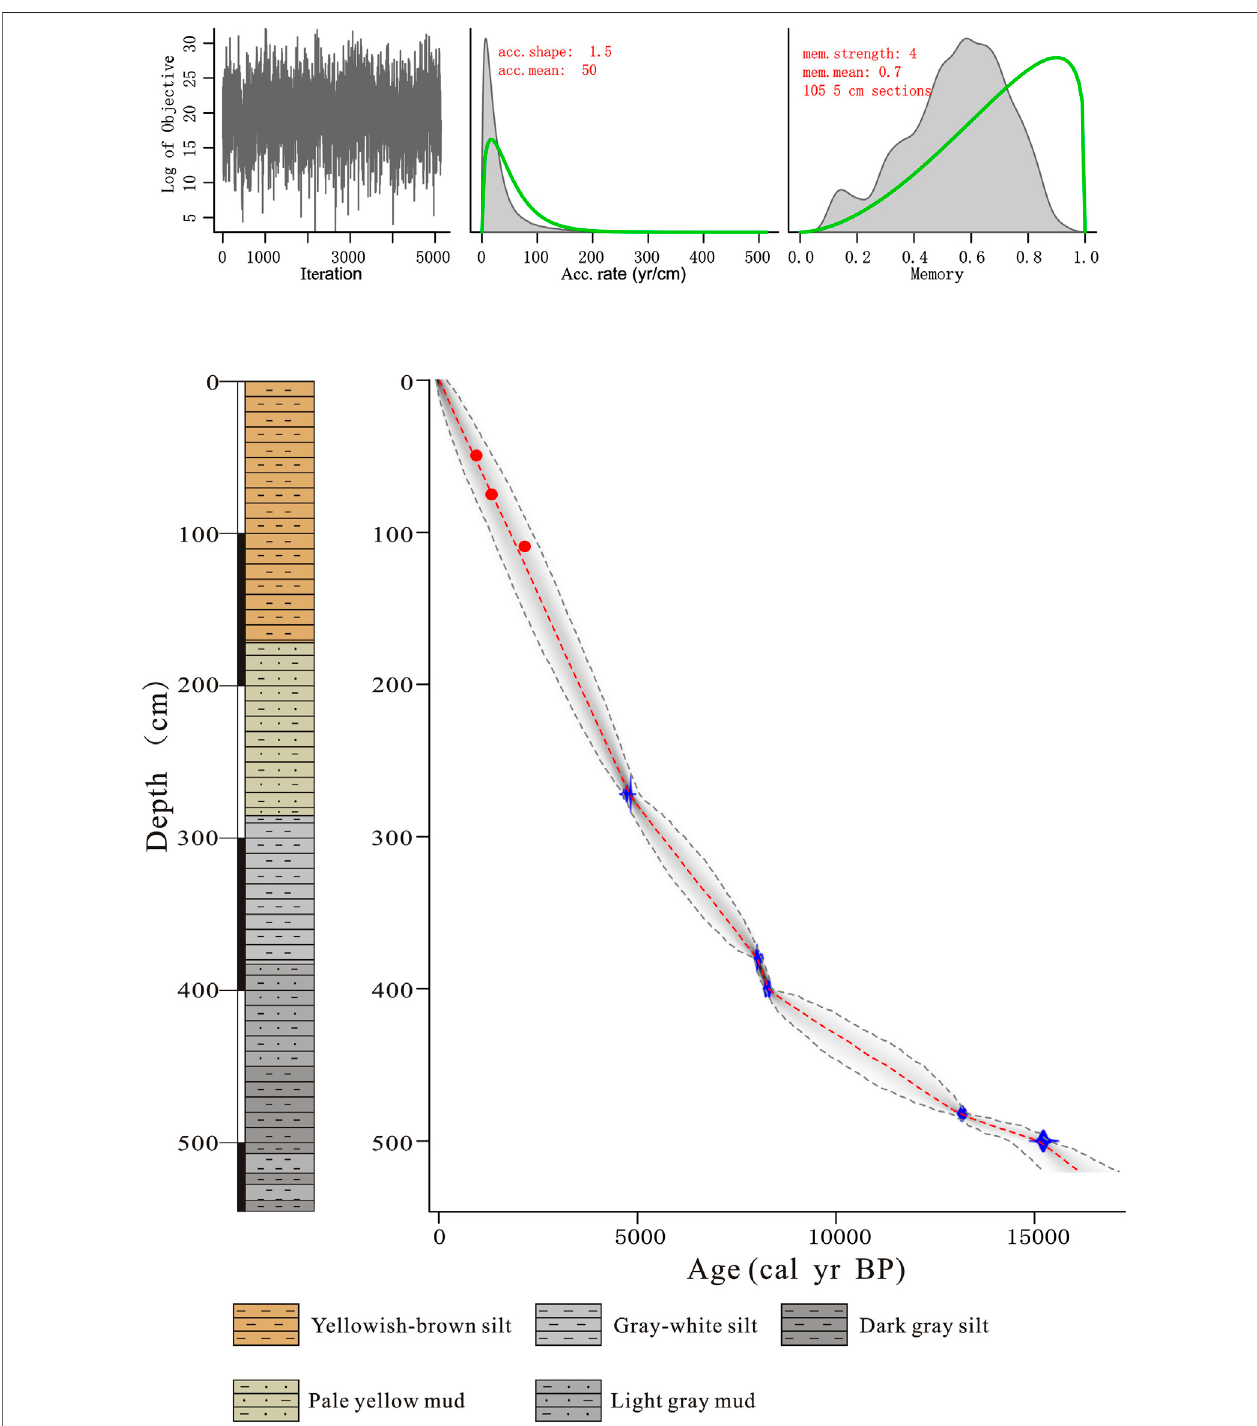
FIGURE 2 | Age-depth model of the HL18-3 core based on bacon. The red solid circles are the RPI age, the blue marks are AMS 14 C ages dated by organic matter, and the green mark is AMS 14 C age dated by plant remains; the shaded part between the gray dotted lines represents the error interval.